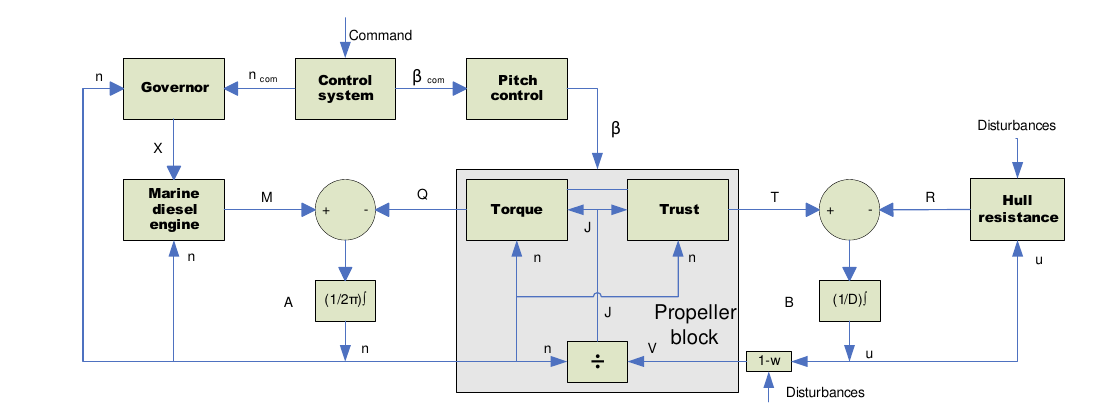
Fig. 5. Block diagram of a ship's propulsion system [6]